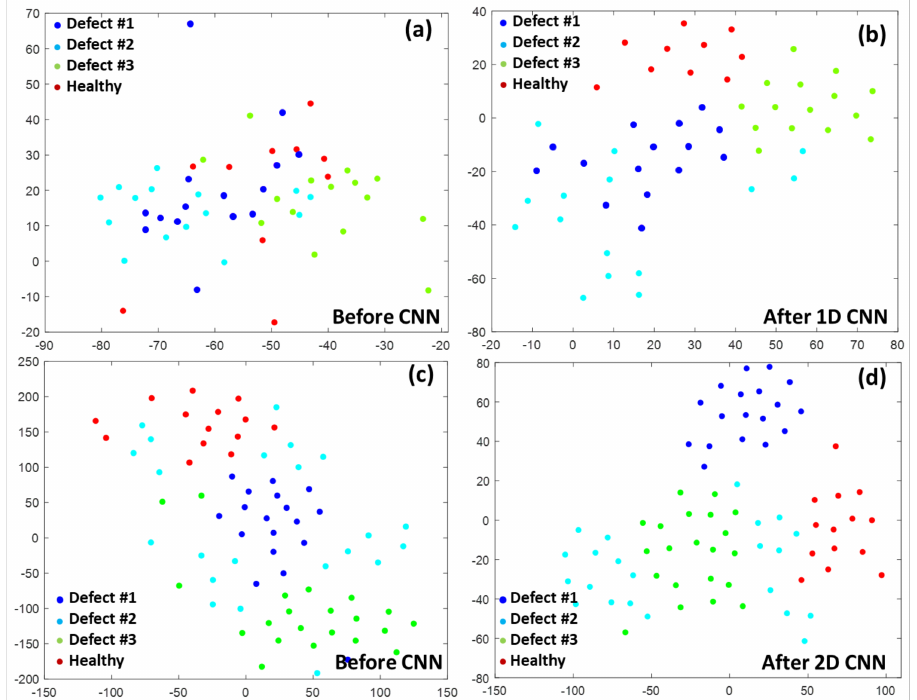
Figure 9. The t-SNE visualization of features for ( a ) 1D CNN non-processed data, ( b ) 1D CNN processed test data, ( c ) 2D CNN non-processed data, and ( d ) 2D CNN processed test